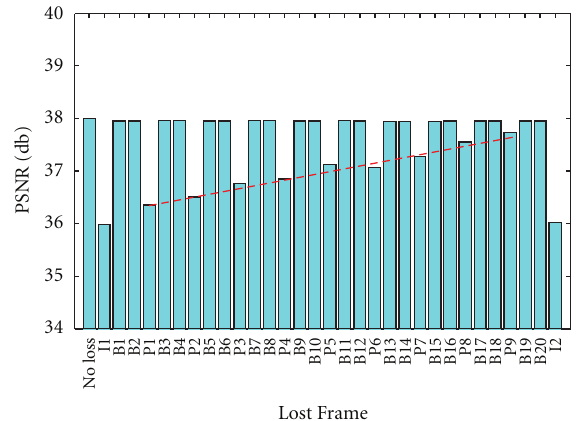
Figure 2: Quality of the received video flow for di ff erent frames lost.